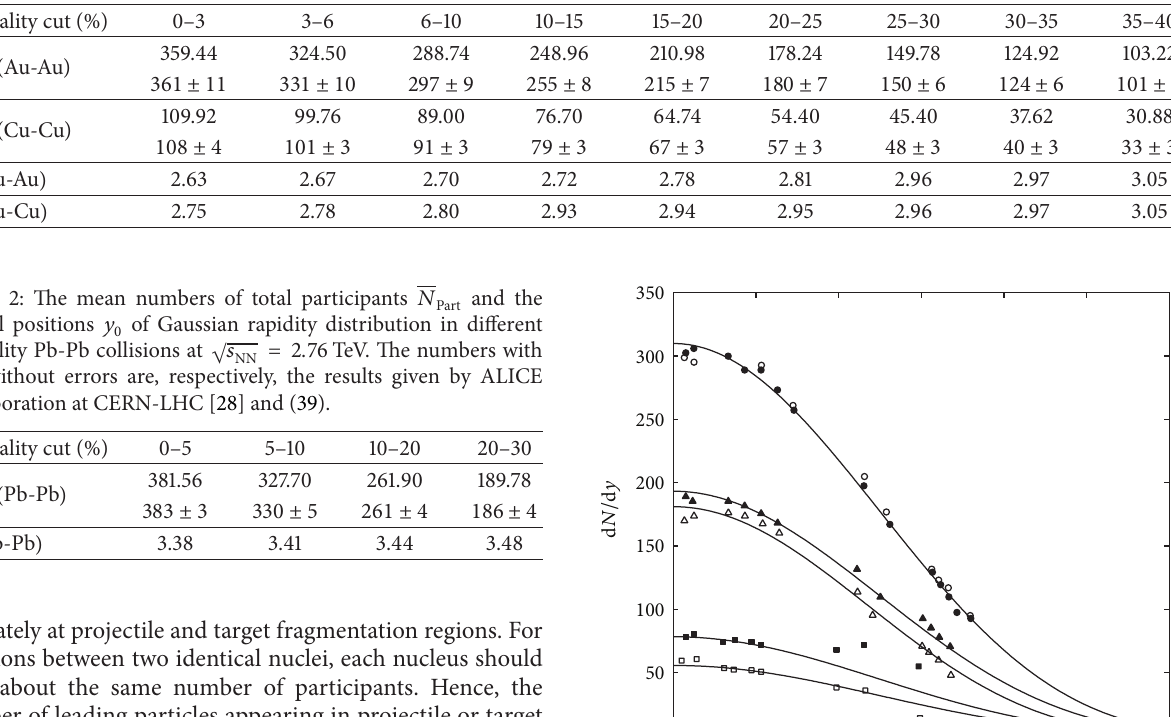
Table 1: The mean numbers of total participants 𝑁 and the central positions 𝑦 0 of Gaussian rapidity distribution in different centrality Part = 200 GeV. The numbers with and without errors are, respectively, the results given by PHOBOS Au-Au and Cu-Cu collisions at √𝑠 NN Collaboration at BNL-RHIC [27] and (39).